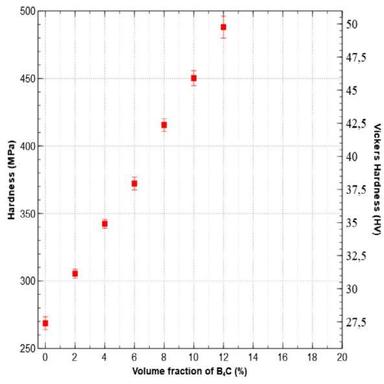
Macro-hardness of Al/B4C composites with different B4C contents.